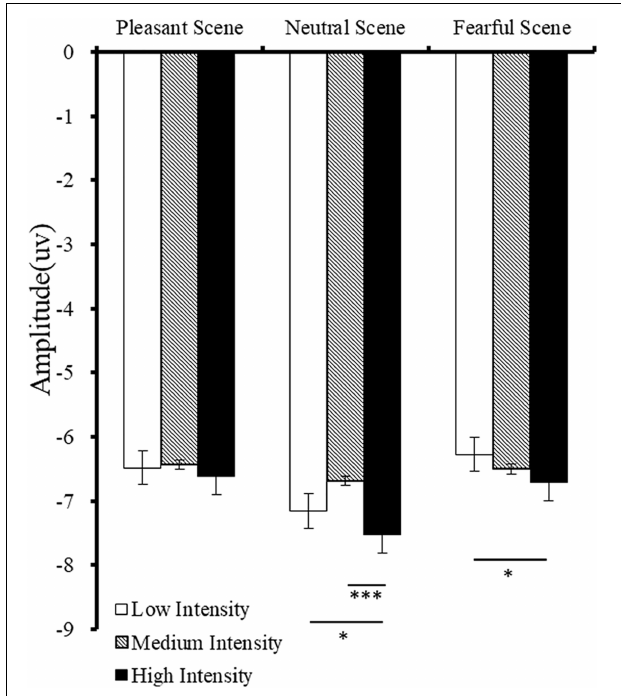
FIGURE 4 | Mean amplitudes of N170 for different fearful facial expression intensities in different scenes. Error bars indicate standard errors, ∗ p < 0.05. ∗∗∗ p <